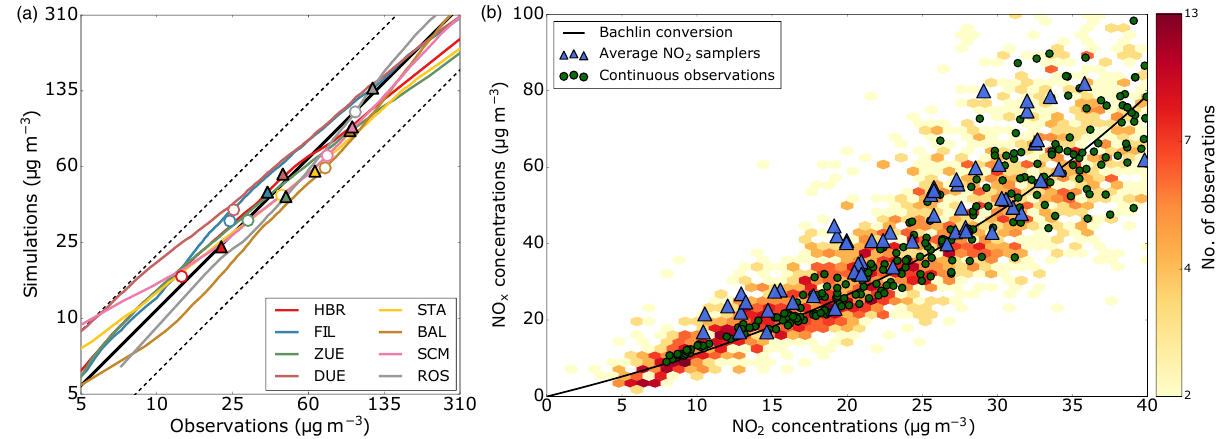
Figure 3. Comparison of observed and simulated NO x and NO 2 concentrations. (a) quantile–quantile plot of hourly NO x concentrations at continuous sites. The solid and dashed black lines are the 1 : 1 line and the 1 : 2 and 2 : 1 lines, respectively. Filled triangles are the 2013–2014 mean and empty circles the median concentrations. Note the logarithmic scale of the plot. (b) Concentrations at passive samplers. Yellow to red coloured background show the comparison between 2-weekly observed NO 2 ( x axis) and corresponding simulated NO x ( y axis). Triangles are the mean values per station averaged over the entire period 2013–2014. For comparison, green dots are the 2-weekly averages of NO 2 and NO x as observed at continuous sites. The black line is a “Bachlin”-type parametrization of the ratio between NO x and NO 2 (Düring et al.,